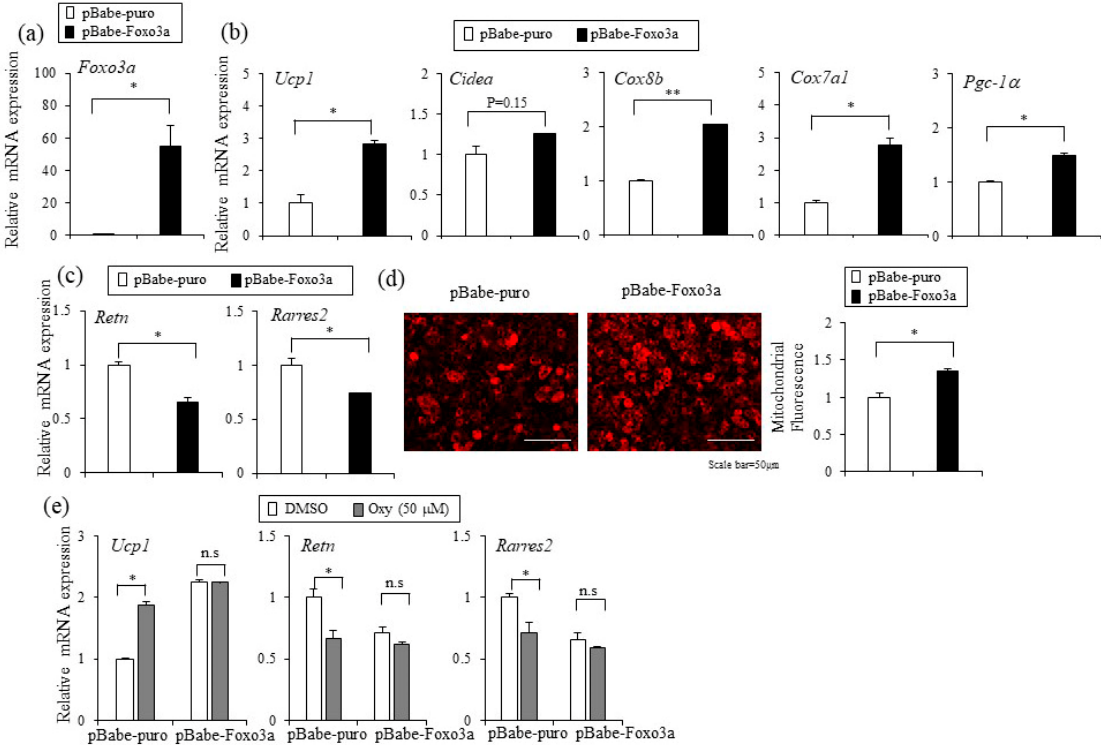
Figure 6. Foxo3a induces expression of Ucp1 and thermogenic genes. ( a ) C3H10T1/2 cells were infected with retrovirus harboring the empty vector control (pBabe-puro) or Foxo3a gene (pBabe-Foxo3a) and large stable pools were selected with puromycin (2 µ g/mL). Expression of Foxo3a in C3H10T1/2 adipocytes was verified by real-time PCR. ( b ) The effects of Foxo3a stable overexpression on the expression of thermogenic genes including Ucp1 , Cidea , Cox8b , Cox7a1 , and Pgc-1 α in C3H10T1/2 adipocytes were determined by real-time PCR. ( c ) Effects of stable overexpression of Foxo3a on white adipocyte selective genes ( Retn and Rarres2 ) in C3H10T1/2 adipocytes were determined. ( d ) Mitochondrial staining (left) by mitochondria-specific CytoPainter (ab112145) in the control plasmid-expressing (pBabe-puro) and Foxo3a -overexpressing (pBabe-Foxo3a) adipocytes. (right) Mitochondrial staining was quantified by NIH Image J software. ( e ) Foxo3a-overexpression abrogates the effects of oxyresveratrol in the regulatory effects on Ucp1 , Retn , and Rarres2 expression. Data represent means ± s.e.m. and are representative of three independent experiments. Each independent experiment was carried out in triplicate. Statistically significant differences were determined using Student’s t -test (* p < 0.05; ** p < 0.005).